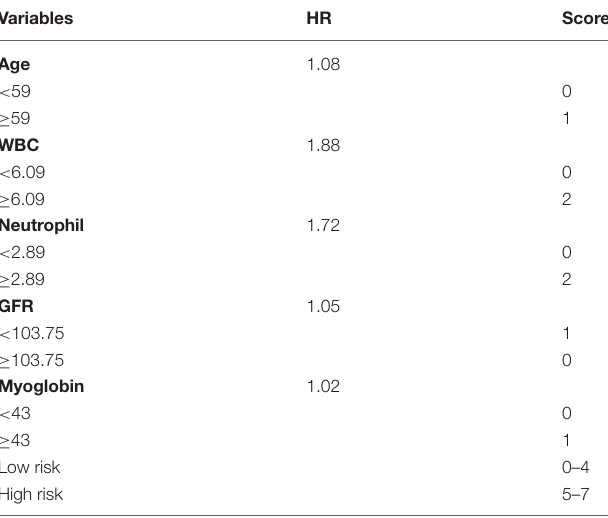
TABLE 3 | Scoring system for prediction of disease severity in COVID-19.